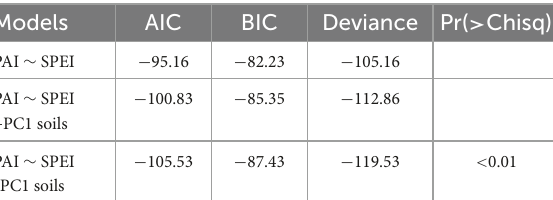
TABLE 2 Statistical parameters comparing the three linear mixed-effects models tested to describe the relationship between